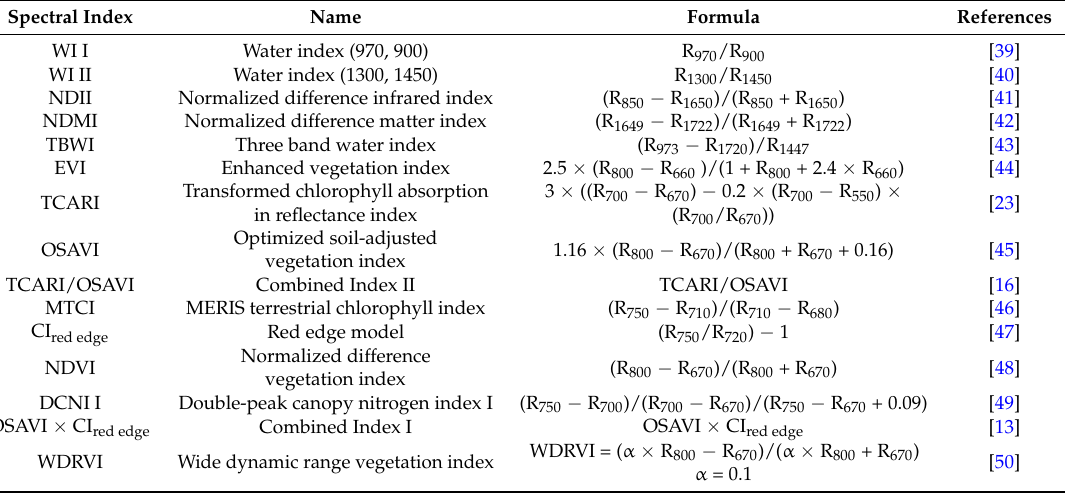
Table 3. Summary of spectral indices